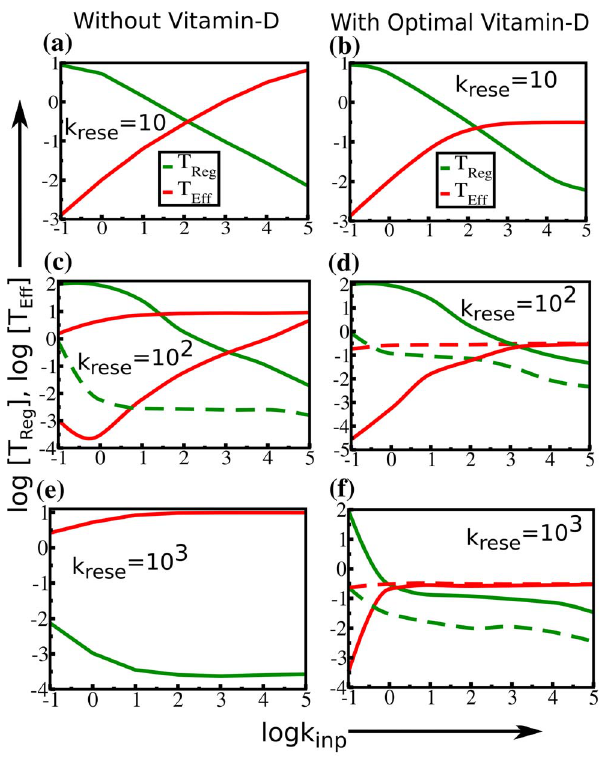
Figure 2. Variation in T-cell concentration under weak to strong regulation. Steady state concentrations of effector T-cells (T Eff , shown in red) and regulatory T-cells (T Reg , shown in green) are plotted against various ranges of pathogenic stimulation ( k inp ) at the three different APC mediated effector T-cell regulations ( k rese ) . We find a stable strongly regulated state at k rese ~ 10 both (a) in absence of vitamin-D and (b) in presence of vitamin-D. The strong regulation remains strong also in presence of vitamin-D at the same k rese value. A bi-stable state appears at k rese ~ 10 2 where both weakly regulated state (shown in dashed line) and strongly regulated state (shown in solid line) can coexist (c) in absence of vitamin-D and (d) in presence of vitamin-D. A stable weakly regulated state appears at k rese ~ 10 3 (e) in absence of vitamin-D. (f) In presence of vitamin-D, the bi-stable state is extended over a wide range of k rese limit. Beyond this limit it falls in a weakly regulated regime. Note that here we consider the vitamin-D related rate constants as, k aD (cid:2) ~ 10 { 7 , k eD (cid:2) ~ 10 { 3 and the other rate values given in Table 1. Optimal vitamin-D concentration signifies the steady state value of vitamin-D ( , 50 nmol/lit).